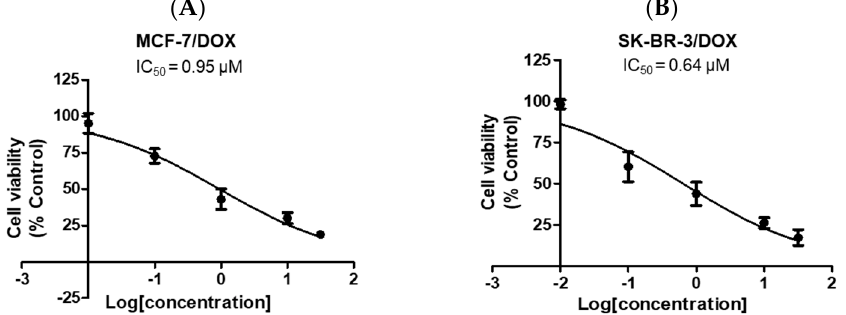
Figure 8. Effects of doxorubicin (DOX) on the viability of MCF-7 and SK-BR-3 cells. ( A ) MCF-7 and ( B ) SK-BR-3 cells were treated with DOX at 0.01, 0.1, 1, 10, and 30 µ M. Control cells were treated with the media containing 0.03% DMSO instead. Cell viability was determined by MTT assay as described in the Materials and Methods. Data are displayed as mean ± SEM from three independent experiments. IC 50 values were calculated using GraphPad Prism, as described in the Materials and Methods.